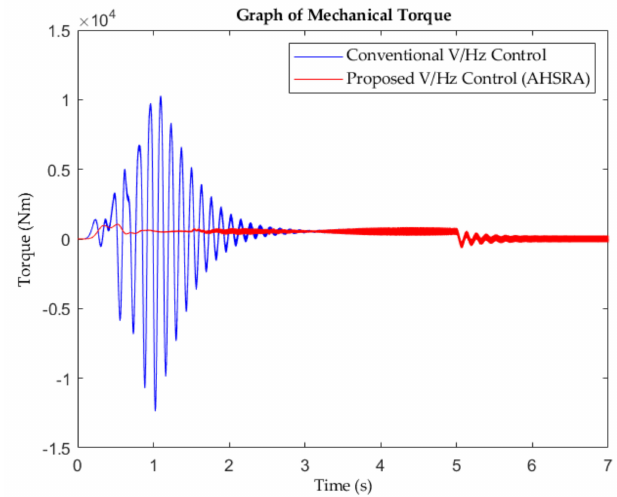
Figure 12. Mechanical torque—AHSRA (red) vs. conventional V/Hz